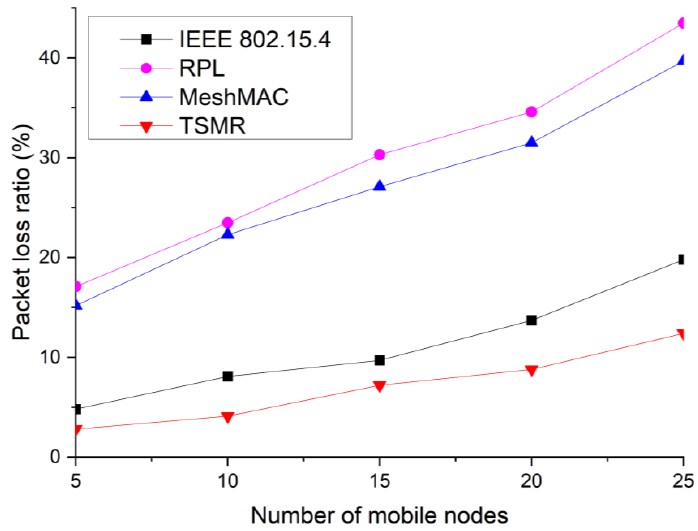
Figure 17. Packet loss ratio as a function of the number of mobile nodes.